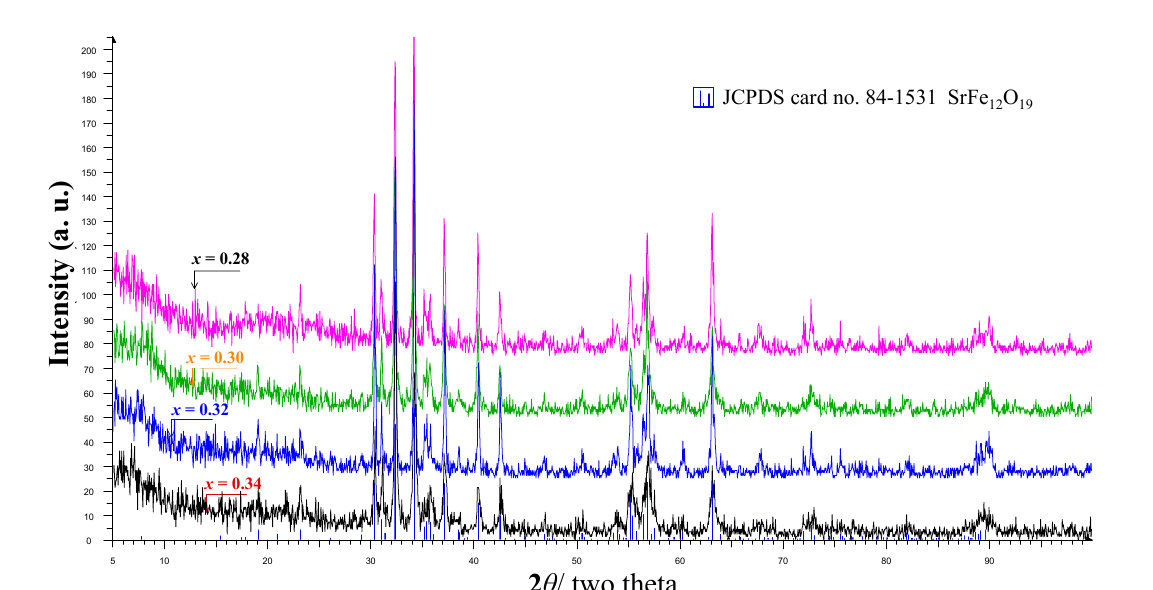
Figure 2. XRD patterns of the ferrite La x Sr 1- x Fe 12-2 x O 19 calcine powders with La content ( x ) from 0.28 to 0.34, and Sr content (1- x ) from 0.66~0.72.